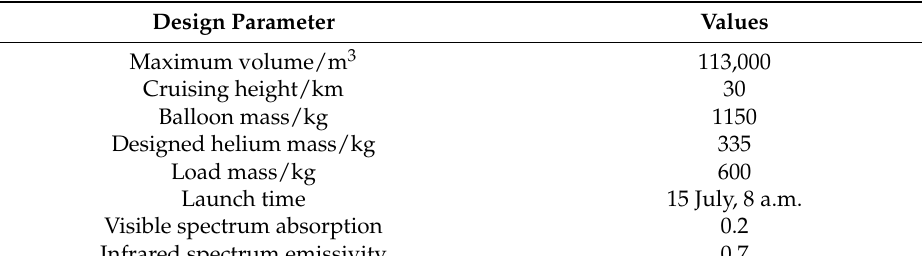
Table 3. Stratospheric balloon parameters.